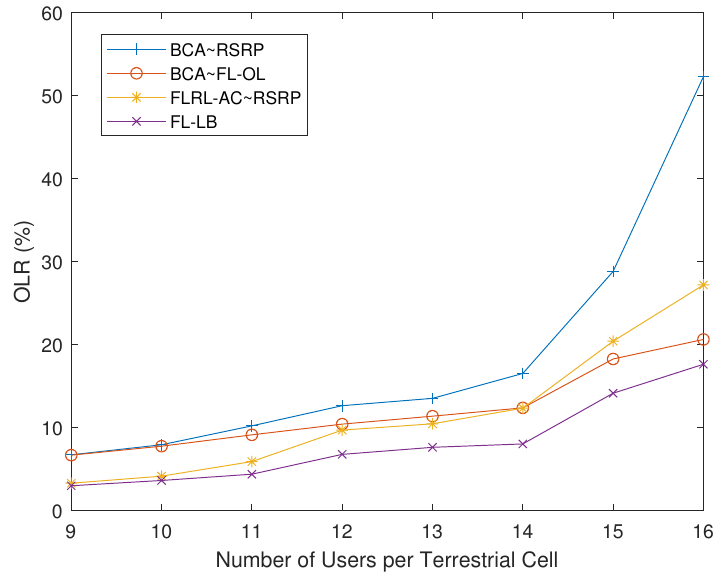
Figure 10. The overload ratio with different joint schemes.